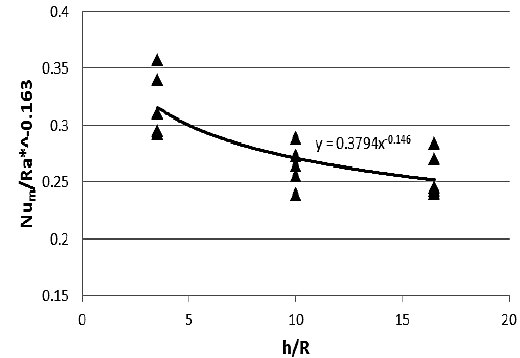
Figure 16.Relation between (Nu m /Ra* -0.163 ) and depth/radius